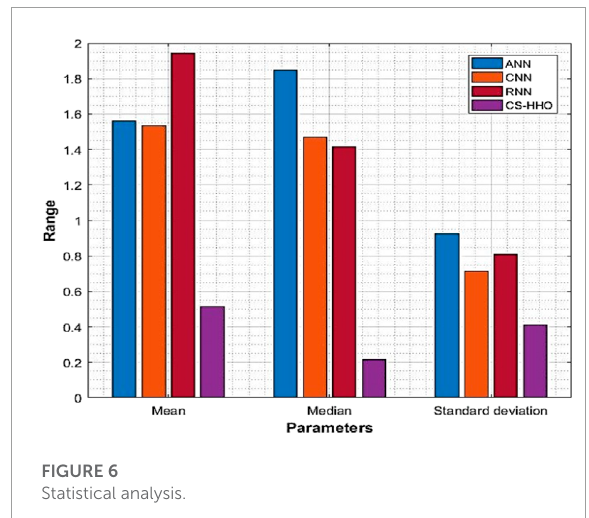
FIGURE 6 Statistical